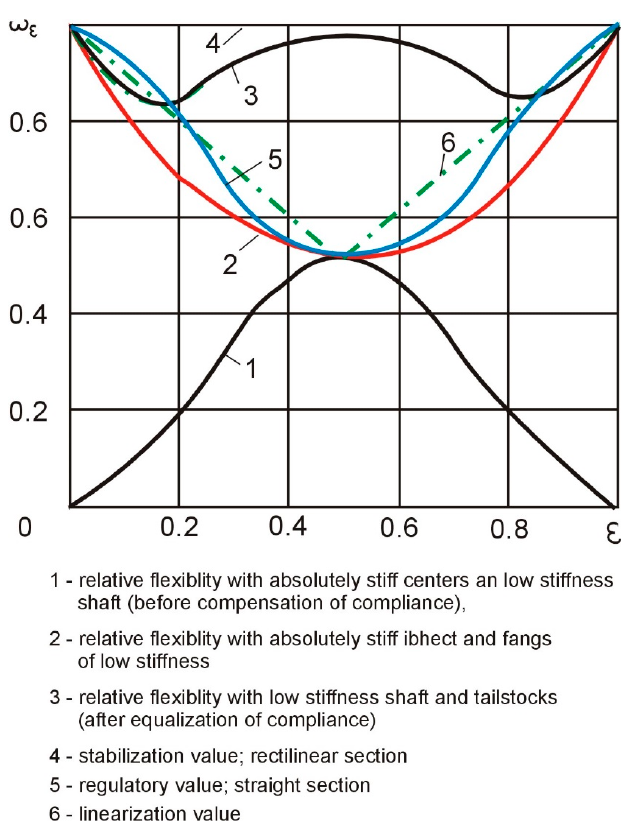
Figure 8. The relative flexibility of the elastic technological systems, depending on the length of machining.